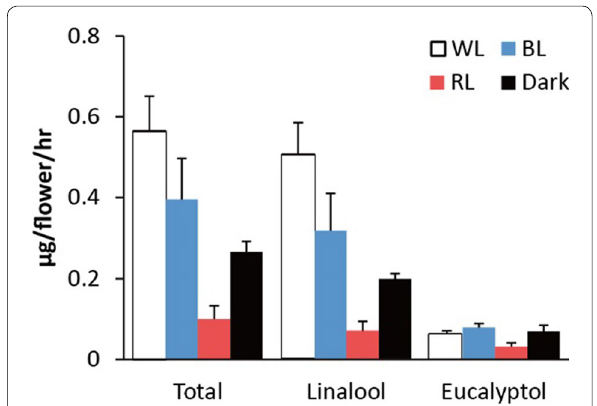
Fig. 3 Emission of monoterpenes from P. I‑Hsin Venus ‘KHM2212’ in different light conditions. The plants were treated with 50 μmol m − 2 s − 1 white (WL), red (RL), and blue (BL) light conditions, and darkness (dark). Scent was collected from six flowers on D Experiments were based on duplicate biological